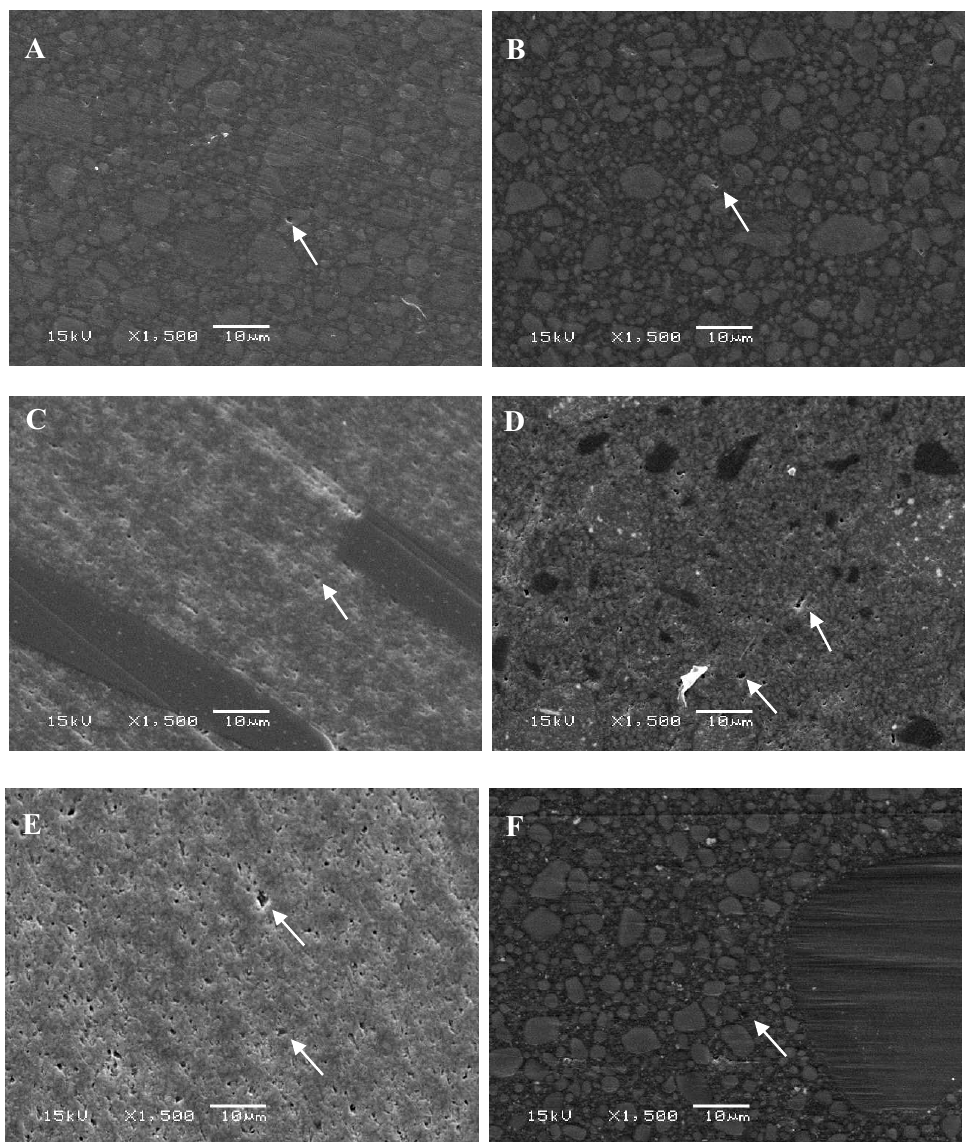
Figure 3. Bar graph showing means of wear depth (µm) with standard deviations (SD) of tested resin composites. Non-statistically relevant variations ( p > 0.05) between the materials are repre- sented by the same letters within the bars.